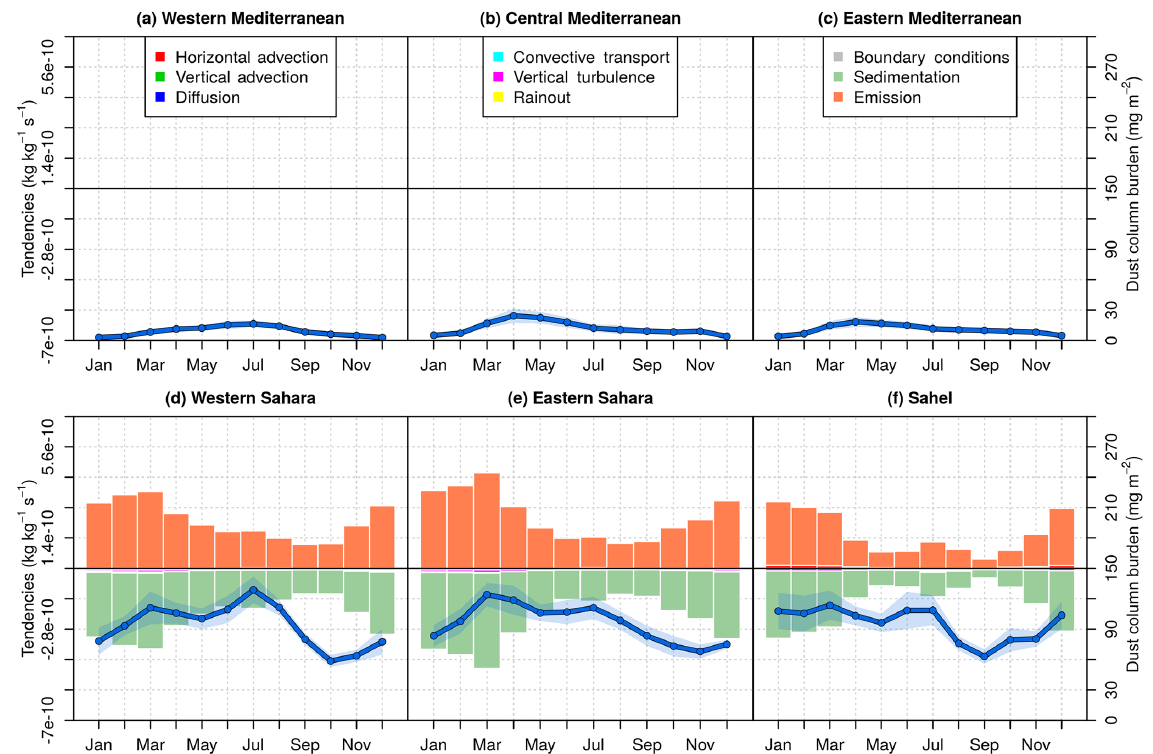
Figure 5. Coarse dust particle column burden of the DUST4 experiment (lines) alongside the production/destruction column tendencies (bars) averaged for the period December 2006 to November 2014. Shaded areas represent the 95% confidence interval of the mean. Table 1. Simulation options implemented in